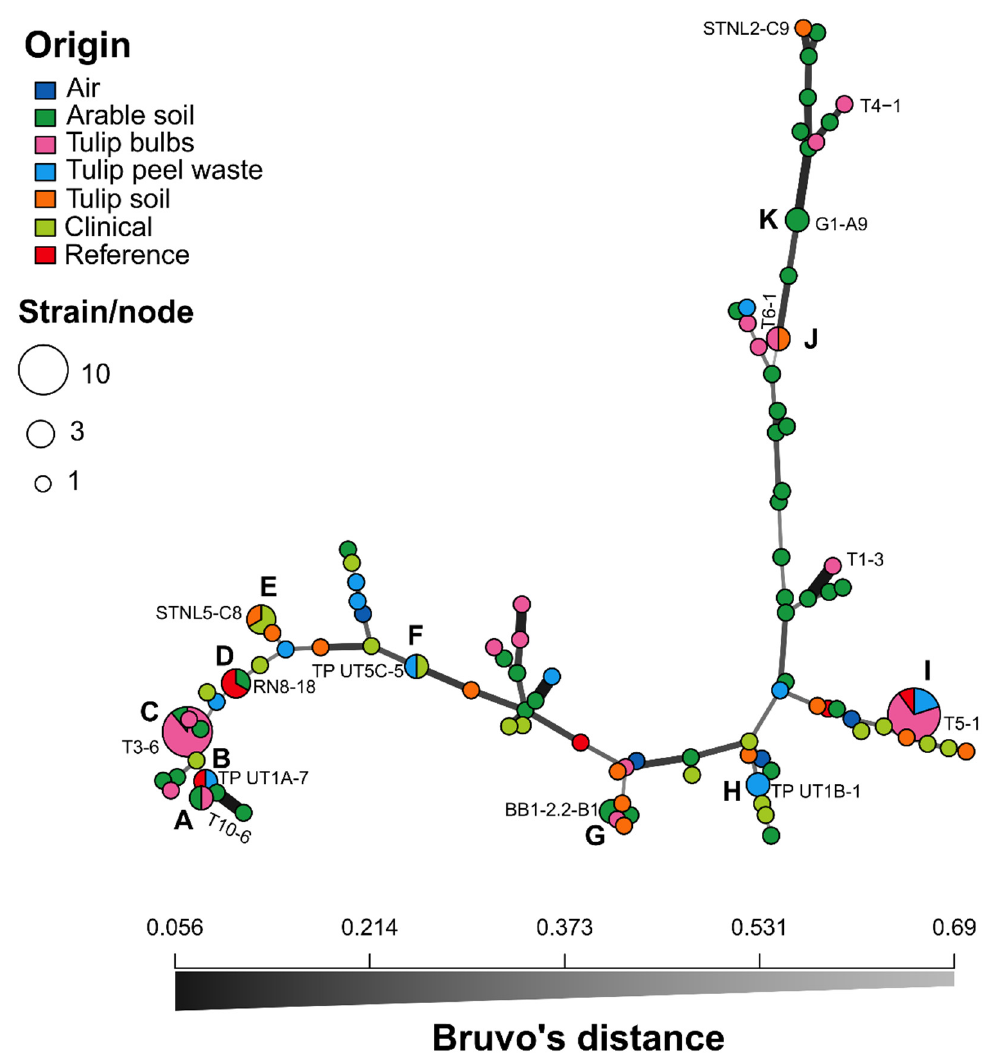
Figure 3. Minimum-spanning networks showing the genetic relationship of Aspergillus fumigatus multilocus genotypes (MLGs) originating from different sources. The relatedness between MLGs is based on Bruvo’s genetic distances, which accounts for the stepwise mutation of microsatellite loci. Each node represents an MLG with one or more individuals. Nodes with multiple isolates (clonal lineages), clusters, are arranged alphabetically. Nodes that are more closely related have darker and thicker edges, whereas nodes that are more distantly related have lighter and thinner edges. Names of a selection of isolates, including all medical strains, are also displayed and all details on strains can be found in Table S1.